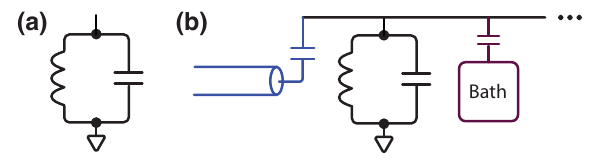
FIG. 2. Circuit model of a superconducting resonator. (a) Lumped element representation of an isolated LC circuit. (b) Circuit of a LC oscillator coupled to a transmission line, which carries the desired microwave probe signals, and a bath, which signifies the presence of other undesired environment couplings that can potentially be